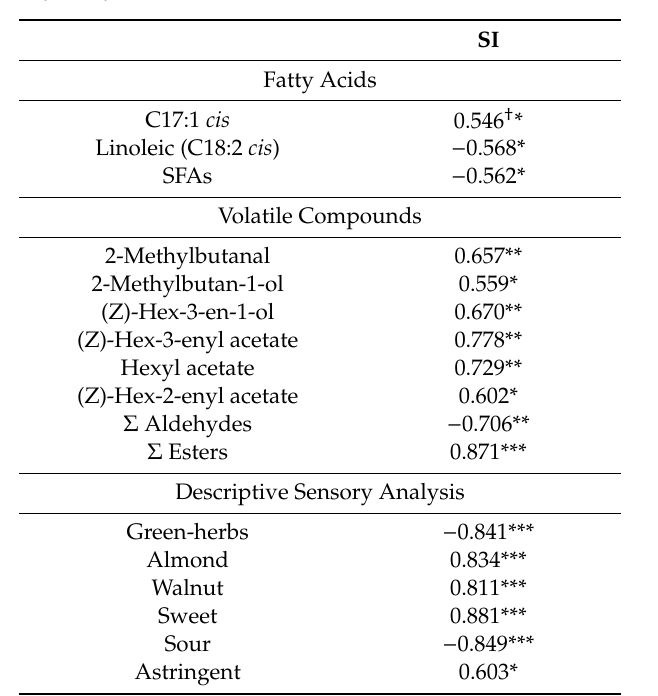
Table 5. Pearson correlation between Stress Integral (SI) and fatty acids, volatile compounds, and descriptive sensory analysis